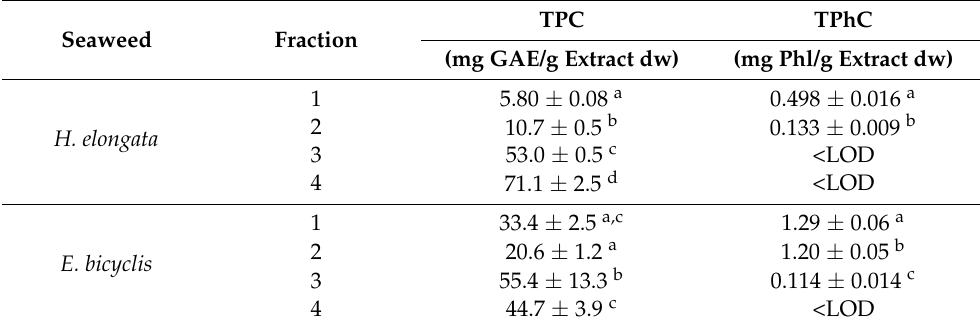
Table 1. Total phenolic content (TPC) and total phlorotannin content (TPhC) of Himanthalia elongata (L.) S.F.Gray and Eisenia bicyclis (Kjellman) Setchell